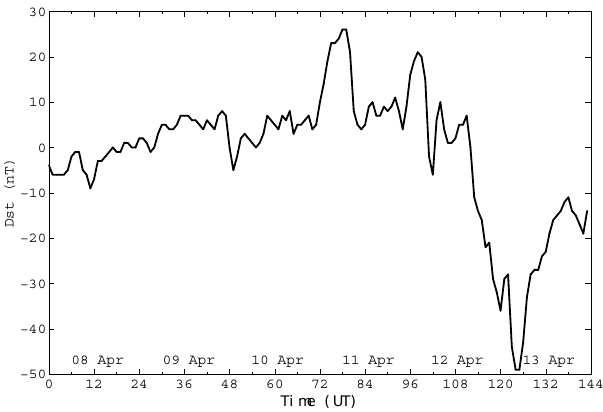
Figure 2. Storm time index Dst for the period of 8 to 13 April